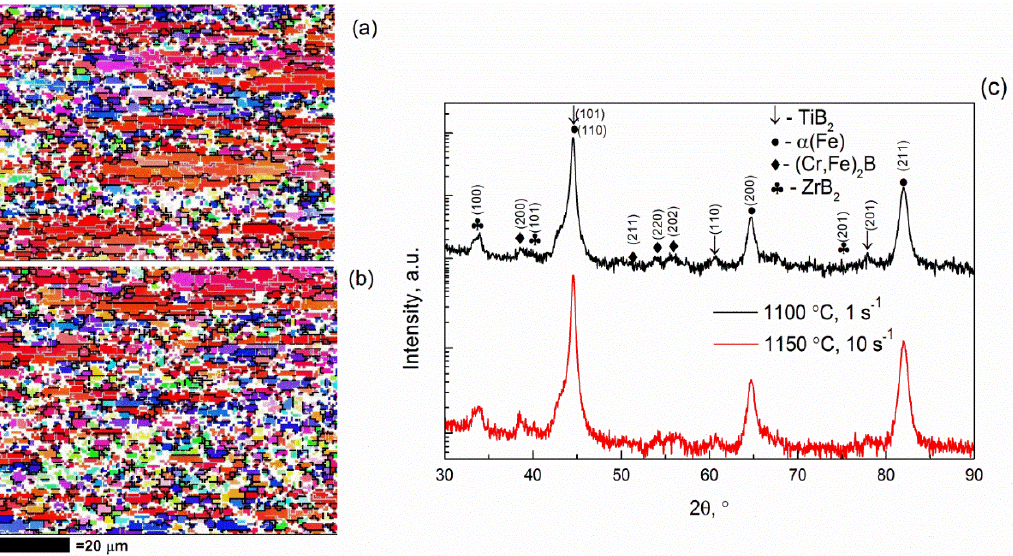
1373 K, 10 s − 1 ( b ); 1423 K, 1 s − 1 ( c ); 1423 K, 10 s − 1 ( d ).